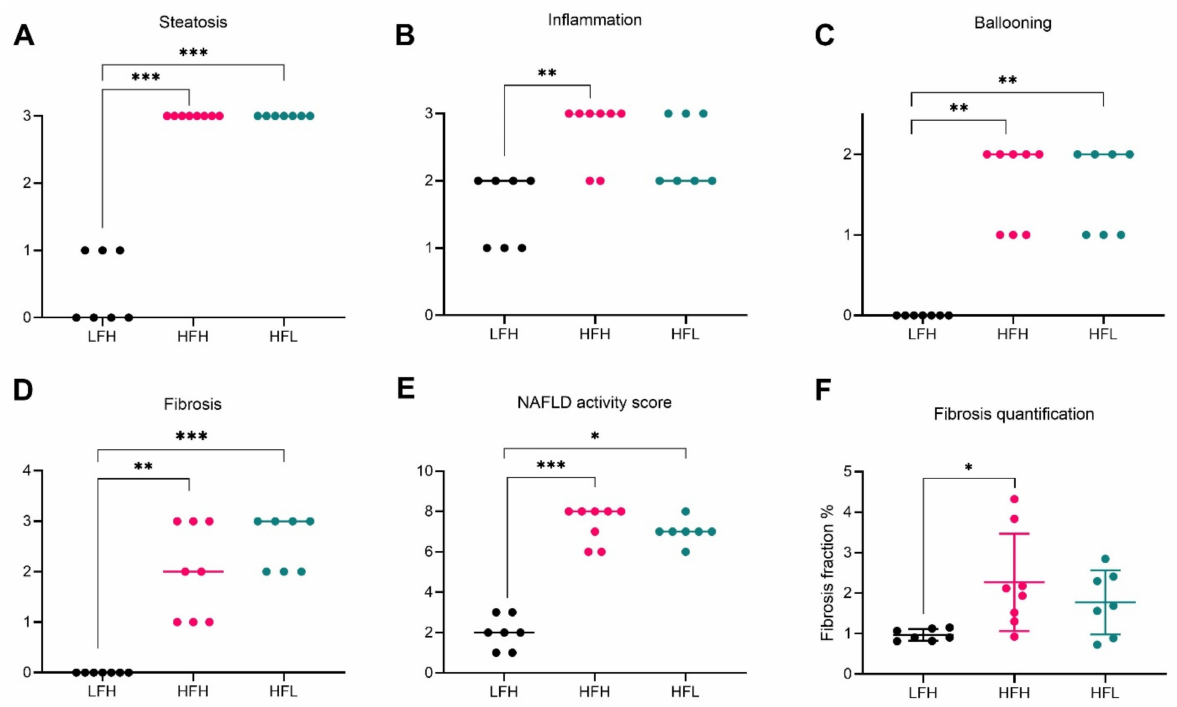
Figure 4. Hepatic histopathological scoring and fibrosis quantification at week 16. Data are rep- resented as individual values (scores) with medians ( A – E ) or means ± SD (F) ( n = 7–8/group). Semi-quantitative scoring results are depicted in ( A ) steatosis, ( B ) inflammation, ( C ) ballooning, and ( D ) fibrosis. ( E ) Cumulative NAFLD activity score for each animal. ( F ) Fibrosis fraction quantified by image analyses of picrosirius red stained sections and displayed as % of total tissue (section) area. Scoring was analyzed by a non-parametric Kruskal–Wallis with a Dunn’s multiple comparisons test, comparing all groups to LFH. For fibrosis quantification, LFH vs. all groups was analyzed by one-way ANOVA with Dunnett’s multiple comparisons test on log transformed data.